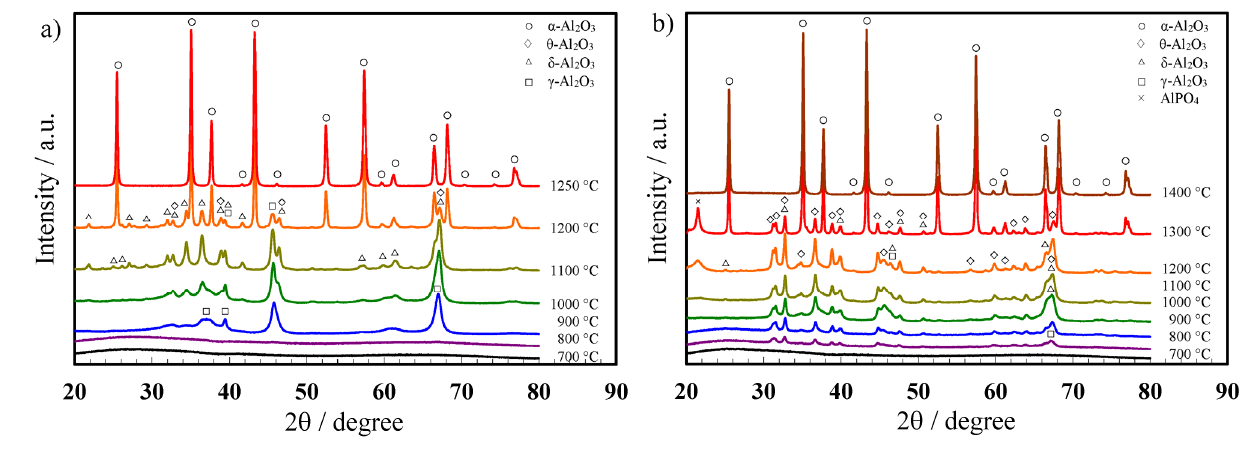
Figure 4. X-ray diffraction patterns for anodic porous alumina films formed in ( a ) oxalic acid at 40 V and ( b ) phosphoric acid at 185 V after heat treatment at various temperatures for 4